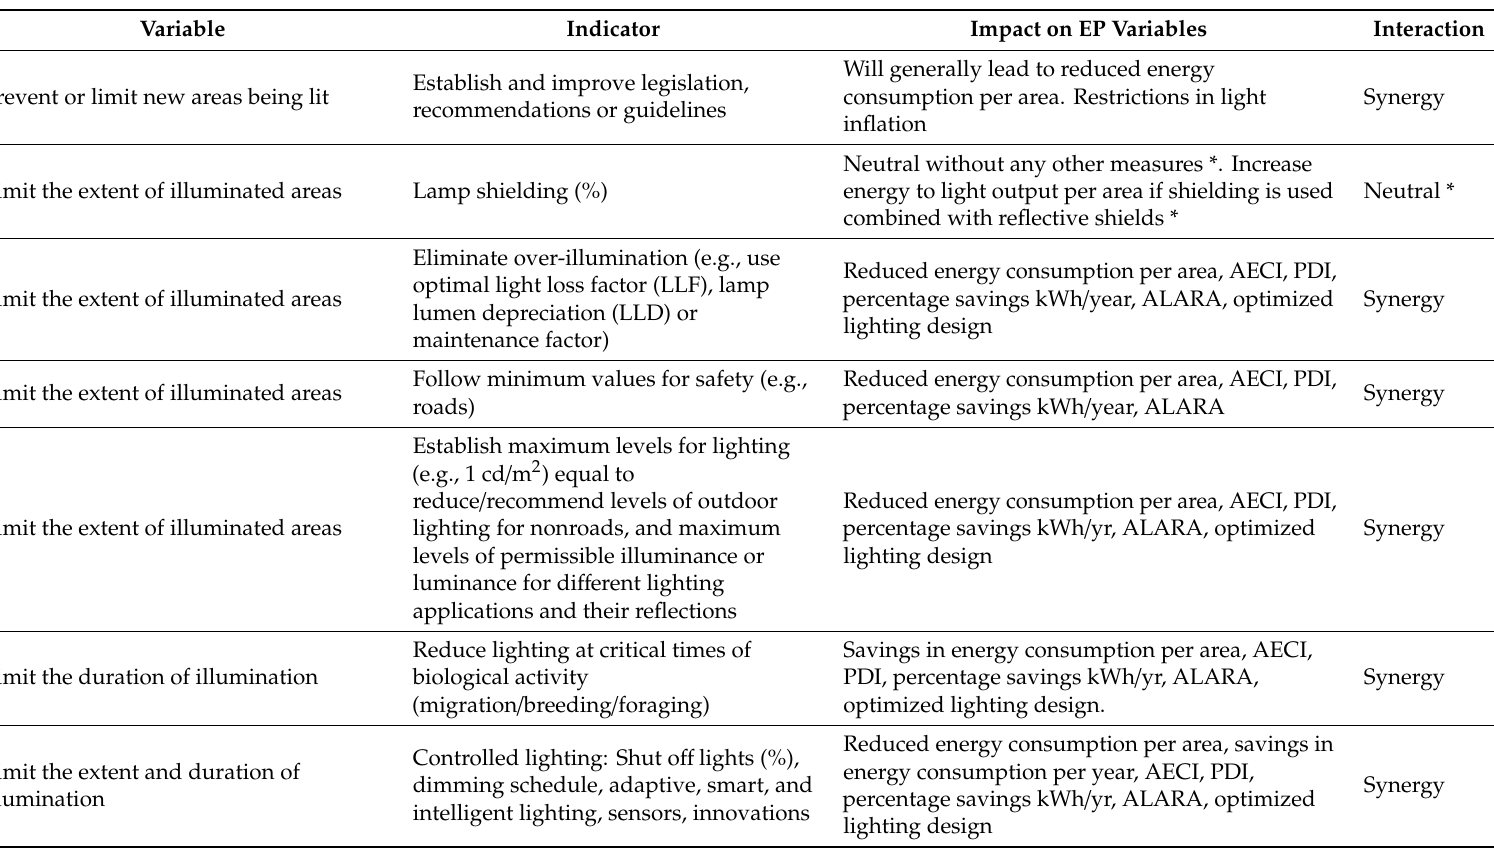
Table 3. Impact and interactions between the sustainability indicators in ecology and environment dimension, and energy performance (EP)